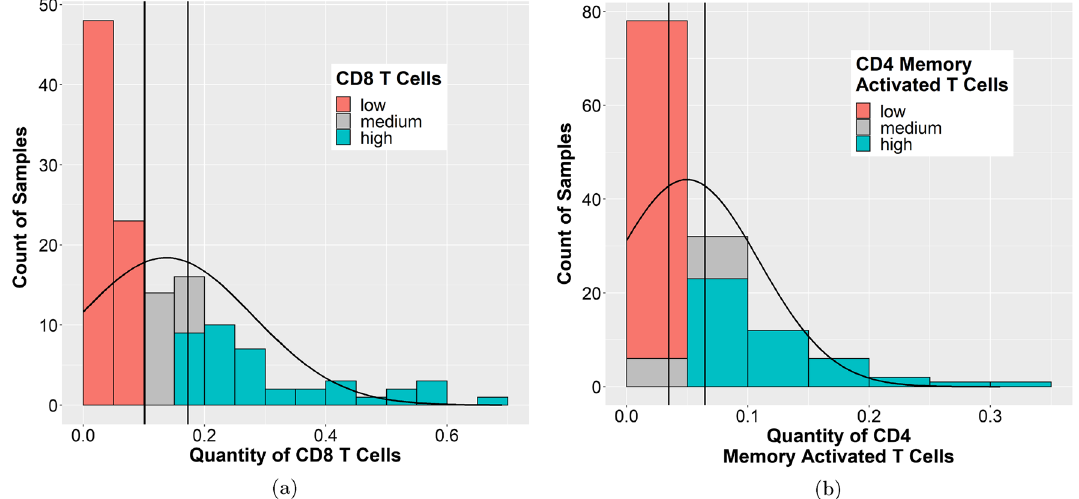
Figure 3. Distribution of the proportion of CD8 T cells or CD4 memory activated T cells across the TCGA TNBC cases. A histogram of the quantity of ( a ) CD8 T cells or ( b ) CD4 memory activated T cells present across the different TCGA TNBC samples was plotted using data generated by CIBERSORT. CIBERSORT assigns a score of arbitrary units that reflects the absolute proportion of each cell type in a mixture. A higher score would indicate a higher proportion of that cell type. Vertical lines represent the cut off (± 0.25 * standard deviation) used to create the “high” and “low” groups. ( a ) and ( b ) Images generated with R 4.0.2 (https ://www.R-proje ct.org) 35